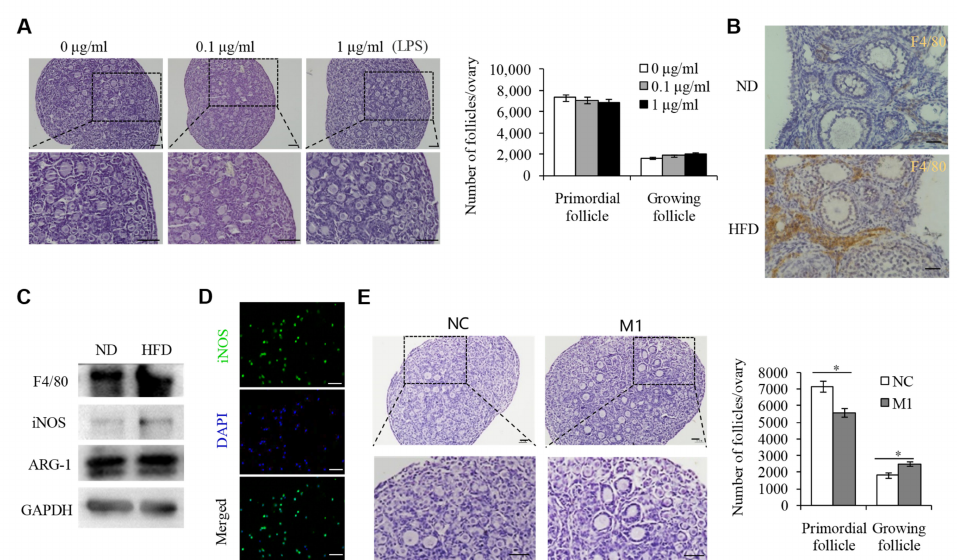
Figure 2. M1 macrophages promoted the overactivation of primordial follicles in HFD mice. ( A ) Representative H&E staining images and follicle number counts in the 3 dpp mouse ovaries after treatment with LPS (0, 0.1, and 1 µ g/mL) for 3 days ( n = 10). Scale bar = 50 µ m. ( B ) Immunohistochemistry staining for the macrophage marker F4/80 in the ovaries of HFD mice. Scale bar = 50 µ m. ( C ) WB assay detecting the protein levels of F4/80, iNOS, ARG-1, and GAPDH in the ovaries of the ND and HFD mice. ( D ) Immunofluorescence analysis detecting iNOS (green) expression in the peritoneal macrophages from LPS-treated mice. DNA was stained with DAPI (blue). Scale bar = 50 µ m. ( E ) Representative H&E staining images and follicle number counts in the 3 dpp mouse ovaries supplemented with M1 macrophage compared to controls ( n = 10). Scale bar = 50 µ m. * p <